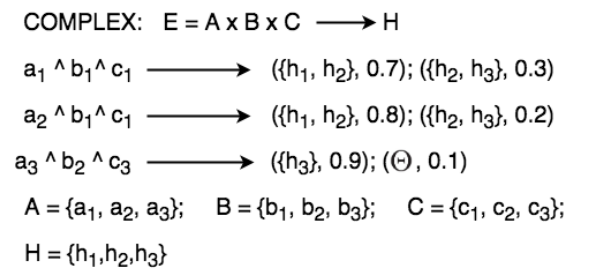
Figure 6. Semi-graph for representing complex